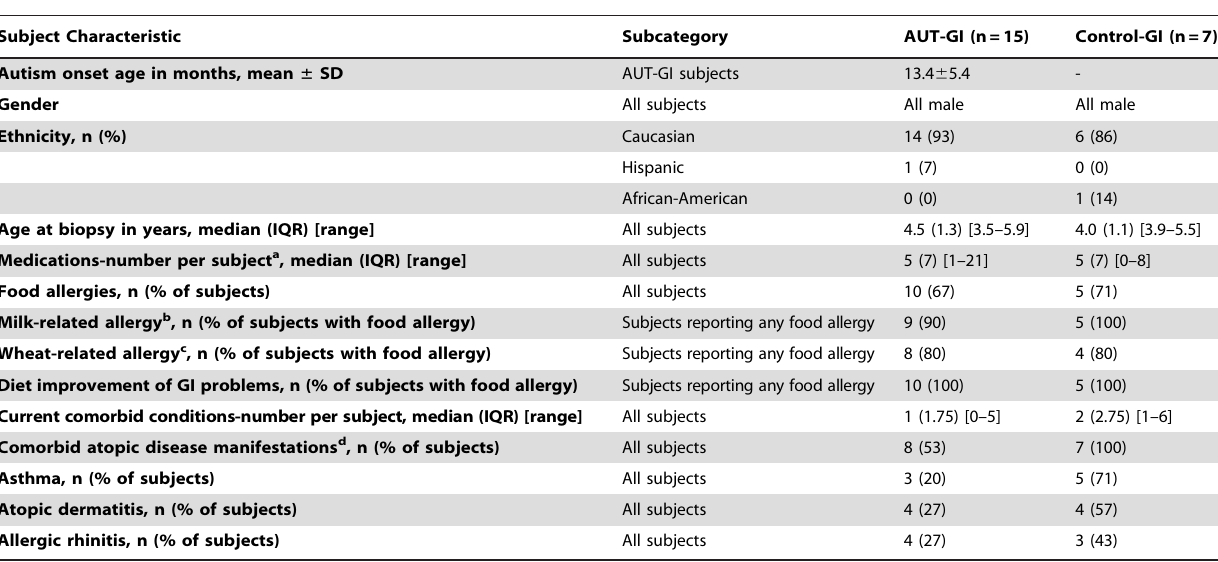
Table 1. Summary of patient